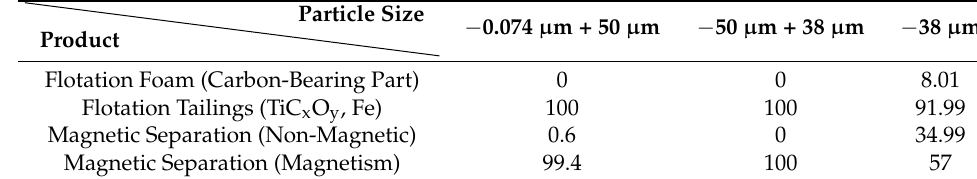
Table 3. Flotation and magnetic separation product yield under different particle sizes (%).